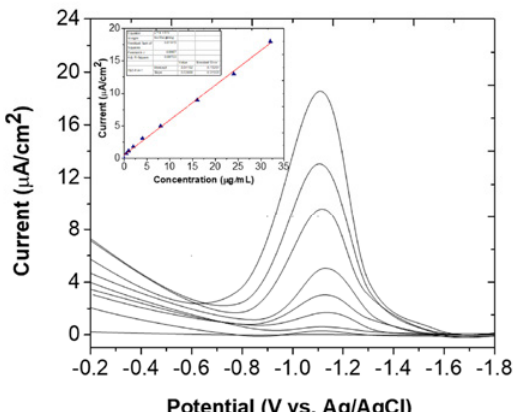
Fig.11. Differential pulse voltammograms recorded at Pd@MWCNTs/GCE for different concentrations of butachlor [0, 0.1, 1.0, 2.0, 4.0, 8.0, 16.0, 24.0 and 32.0 μg ⸳ mL −1 (from bottom to top)] in 0.10 M phosphate buffer solution (pH 6.0); accumulation potential –1.13 V; accumulation time 80 s; pulse amplitude 30 mV; scan rate 50 mV s -1 ; Calibration curve of butachlor